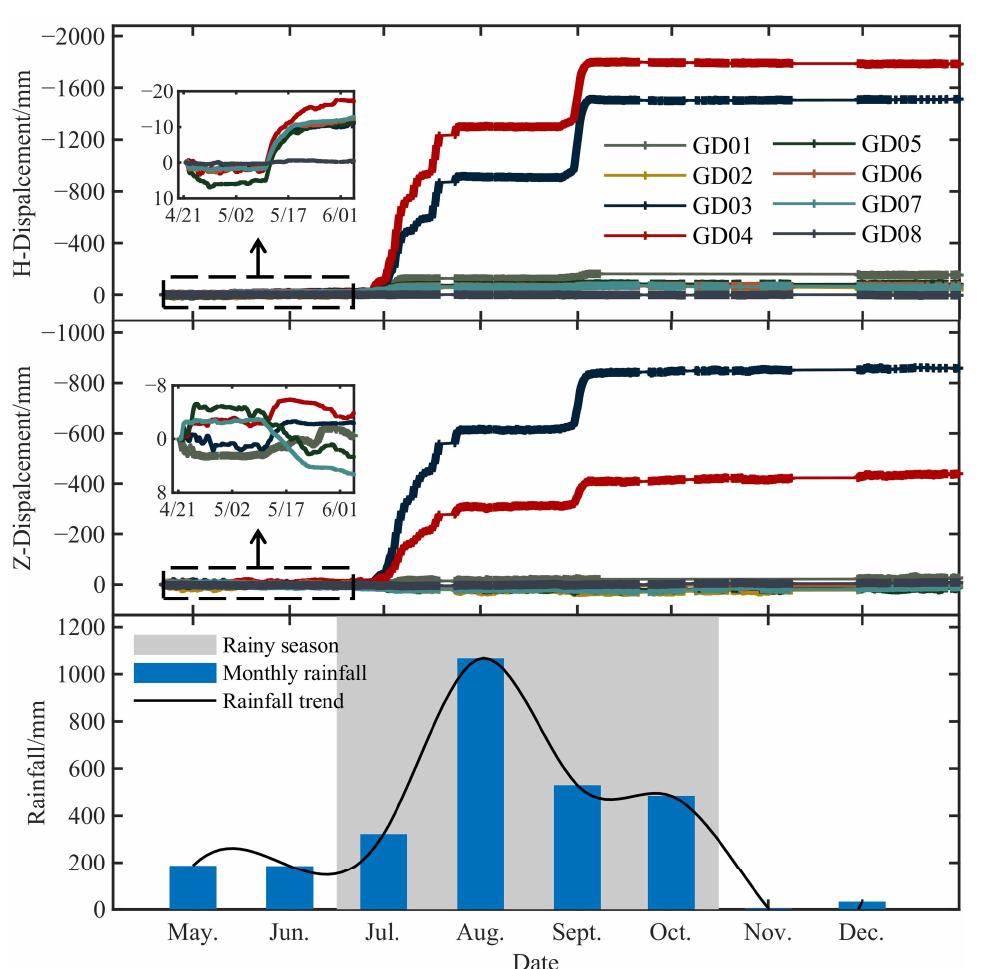
Figure 10. Data recorded by the monitoring system. In each direction, a partial zoom was produced for the pre-June data.